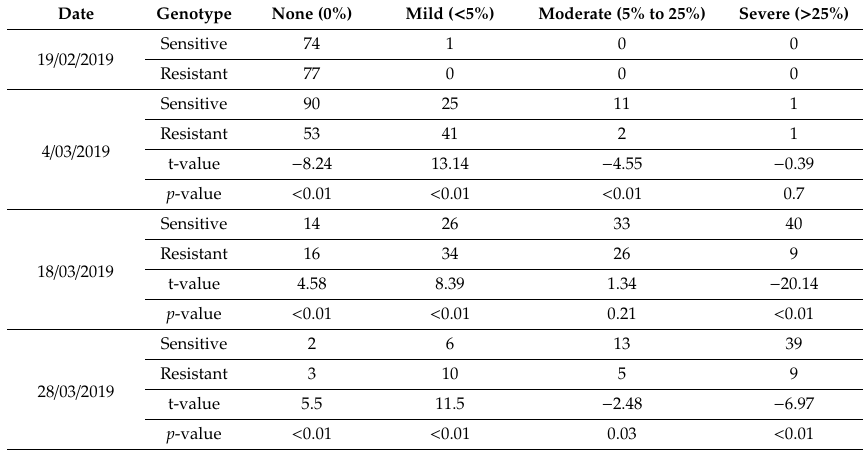
Table A3. The total number of leaves per genotype per O 3 -induced visible foliar injury according to the injury index from the growing stage to harvest for Phaseolus vulgaris . Post-hoc paired t-test was carried out with 12 simulated samples and the p -value is